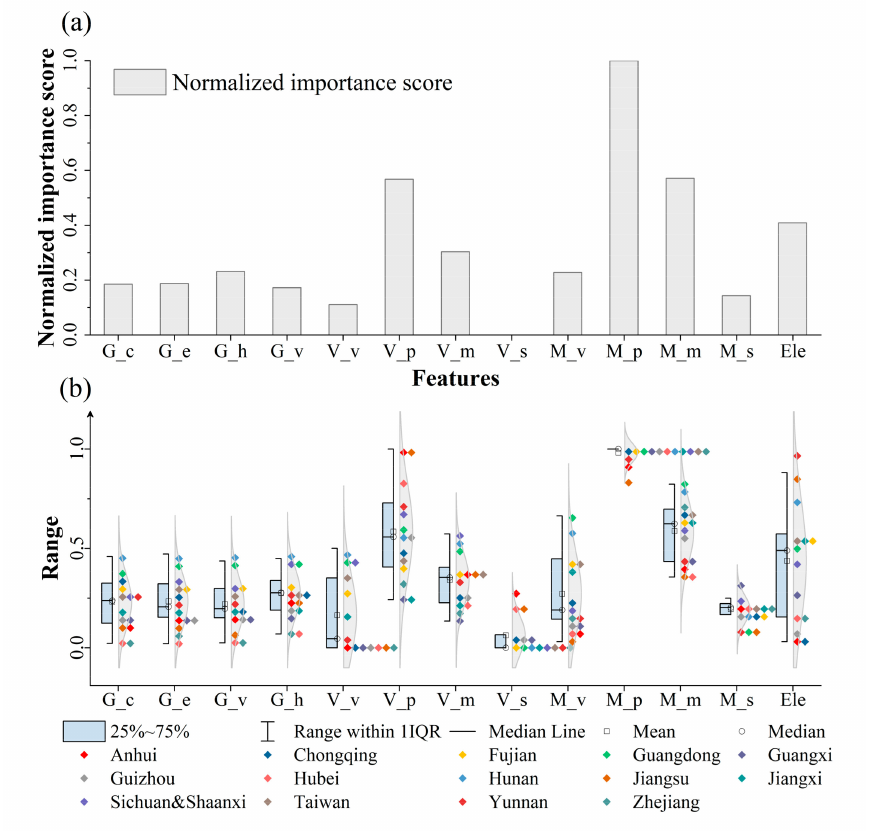
Figure 8. Histogram of average normalized importance scores of classification features ( a ) and the box plot of features’ importance difference in 15 provinces ( b ). G_c: GLCM_contrast;